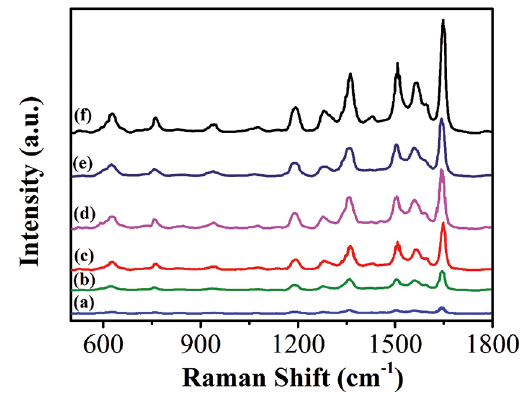
Figure 7: SERS spectra of 10 ─4 M RhB molecules on (a) CA-RGO- Ag-1, (b) CA-RGO-Ag-2, (c) CA-RGO-Ag-3. (d) CA-RGO-Ag-4,